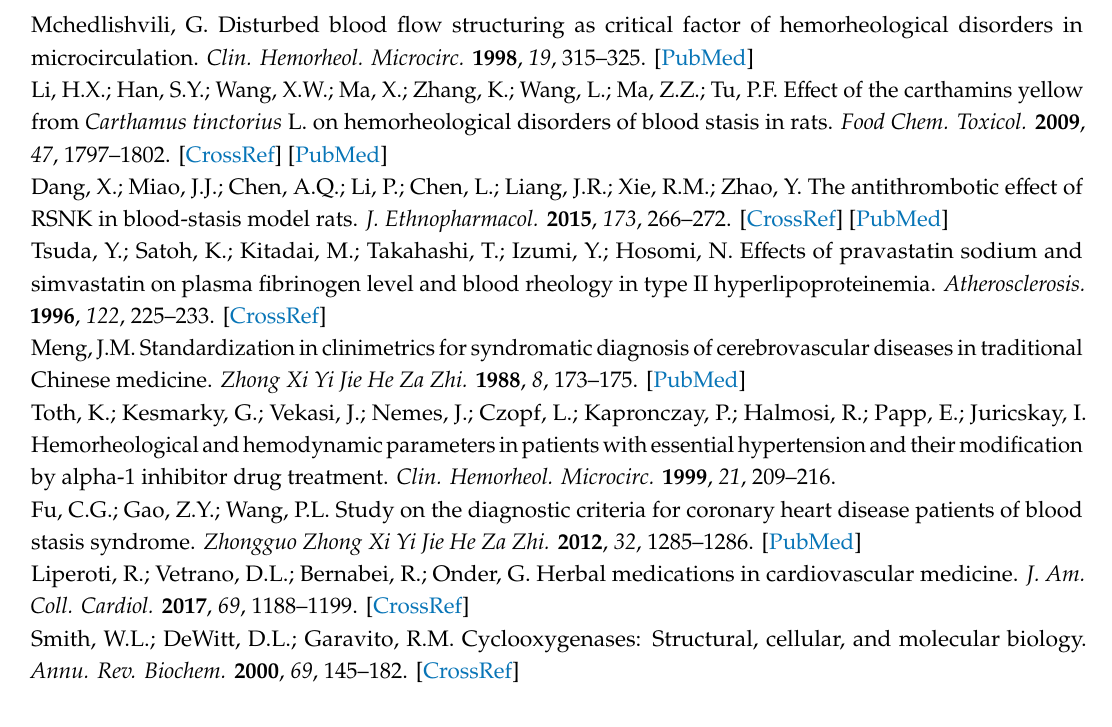
Supplementary Materials: The following are available online. Figure S1: Typical UPLC-Q-TOF / MS total ion chromatograms of rat plasma in each condition in positive (A) and negative ion modes (B); Figure S2: PCA score plots of plasma analyzed by UPLC-TOF / MS in positive and negative modes; Figure S3: S-plots of the corresponding OPLS-DA models in positive and negative ion modes; Figure S4: Heatmap and cluster analysis of the significantly changed metabolites in di ff erent groups; Table S1: Comparison of the metabolites relative intensity in di ff erent group. Table S2: Pathway analysis results from